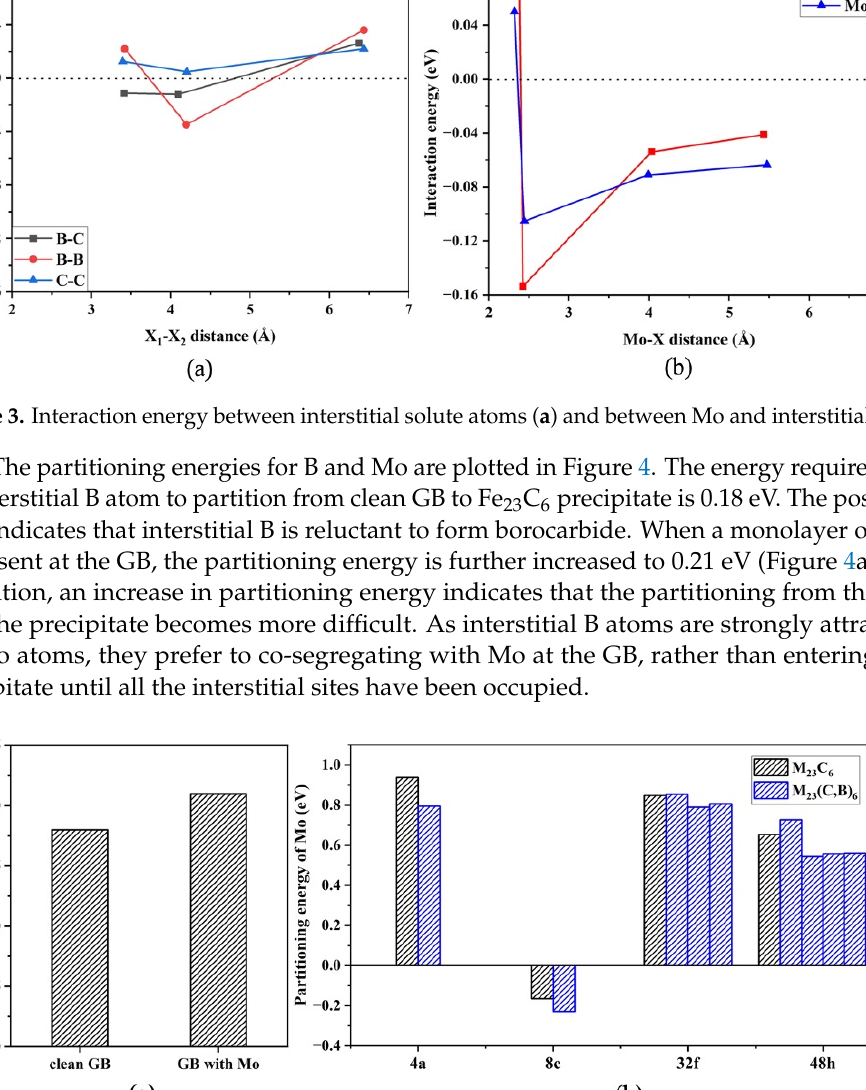
Figure 2. Segregation energy ( a ) and GB energy ( b ) of different systems.